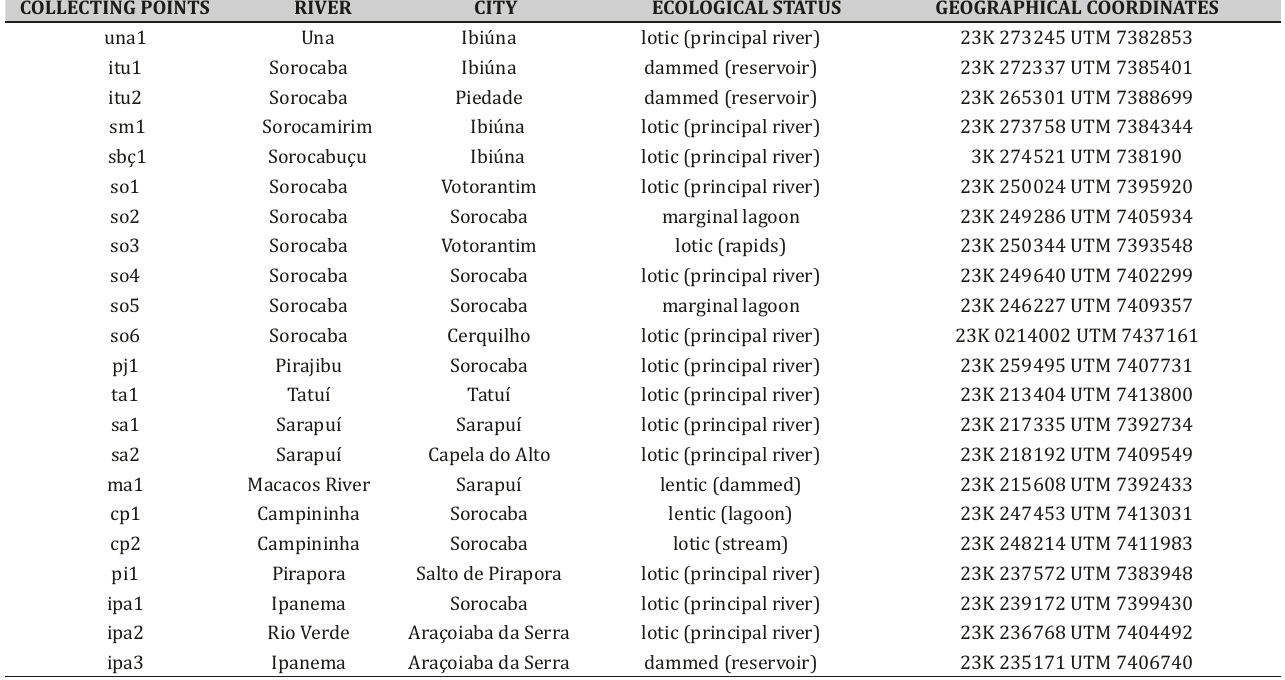
Characterization of the collecting points in Sorocaba River Basin (SP, Brazil), their location, ecological status and geographical